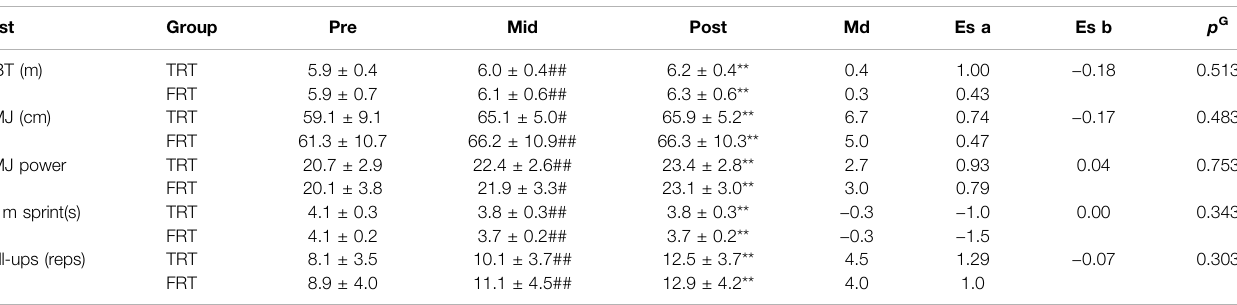
MBTmedicineballthrow,CMJcountermovementjump,TRTtraditionalresistancetraininggroup,FRTfunctionalresistancetraininggroup,MDmeandifferencePost-Pre,ESaeffectsizes within the group as Cohens d, ES b effect sizes between groups as Cohens d, p G value of the difference between groups, Mid-Pre # p < 0.05 ## p < 0.01, Post-Pre ** p <